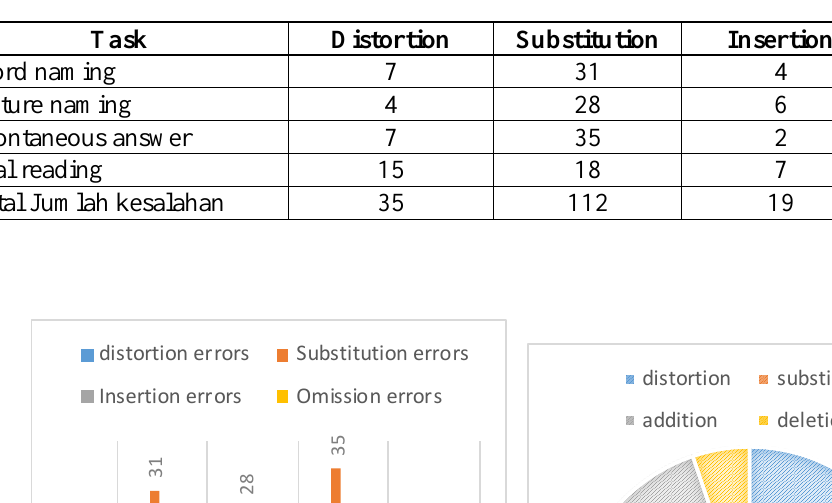
Table 6. Distribution of Phonological Errors